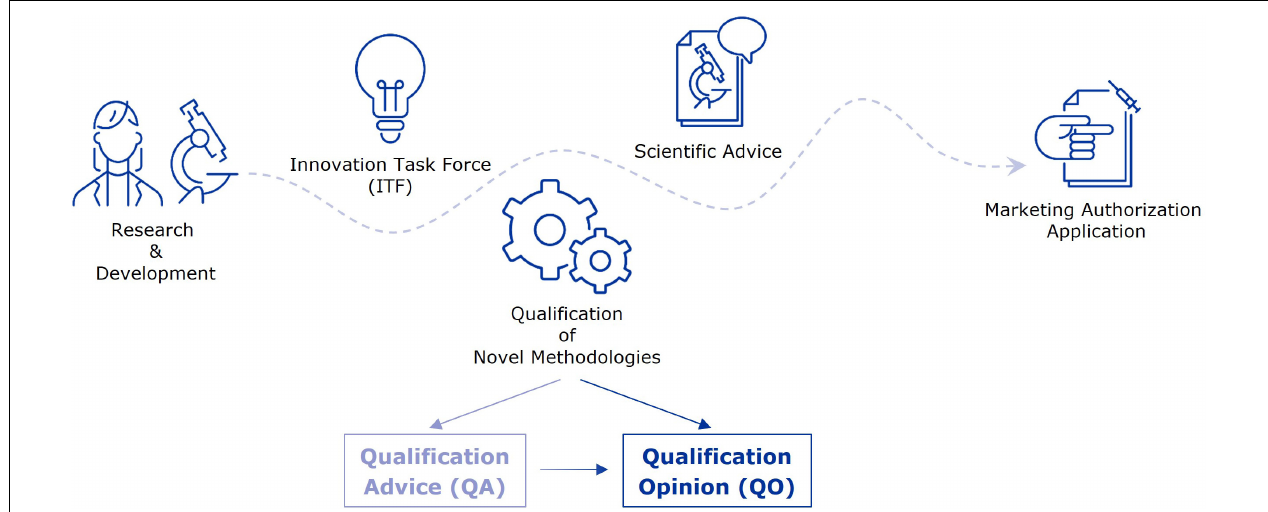
FIGURE 1 | From early-stage research to marketing authorisation–EMA support mechanisms for evidence generation strategies. This figure highlights a selection of interaction platforms at EMA through which applicants can receive guidance and feedback on their evidence generation strategy towards a marketing authorisation